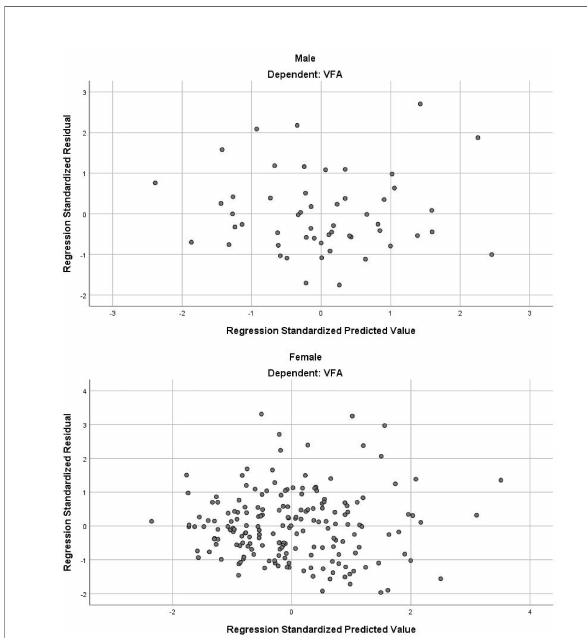
FIGURE 1 | The residual scatter plot of standardized predicted value and standardized